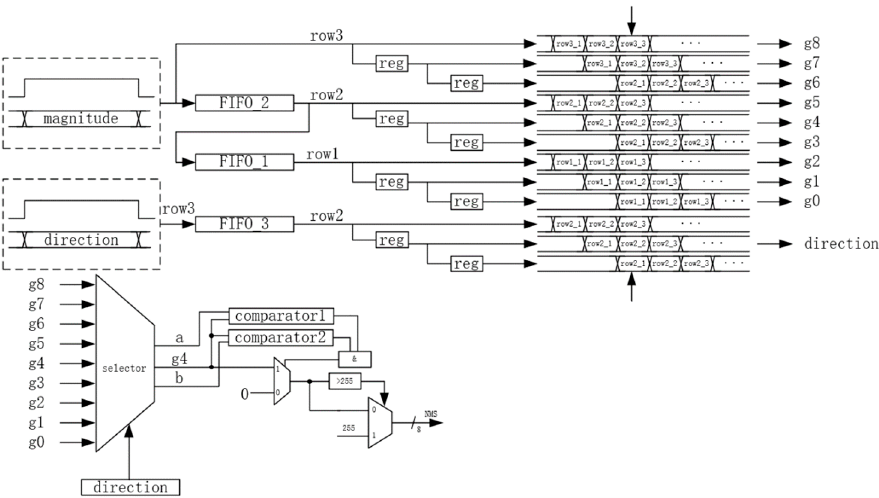
Figure 9. Architecture of NMS.